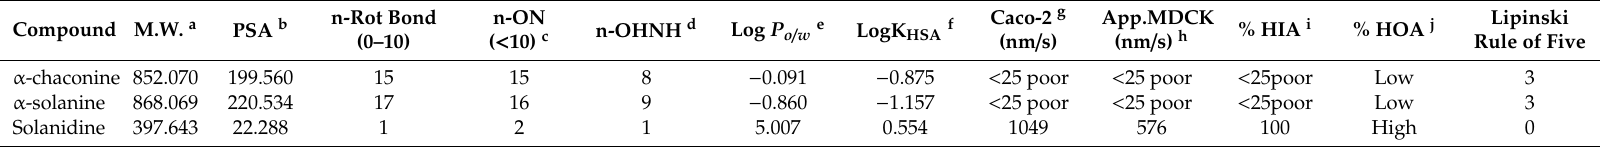
Table 4. Calculated drug-likeness properties for glycoalkaloids α -solanine, α -chaconine, and solanidine. Compound M.W. a PSA b α -chaconine